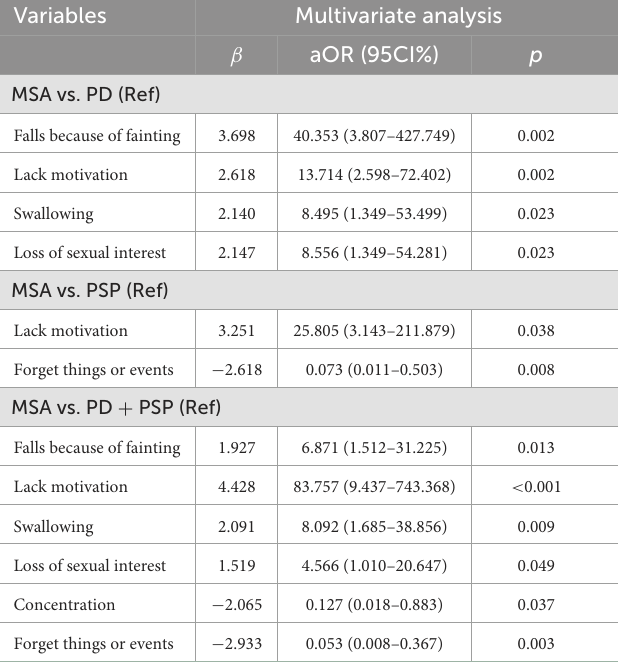
TABLE 2 Multinominal logistic regression analysis of non-motor symptoms between MSA, PD, and PSP.